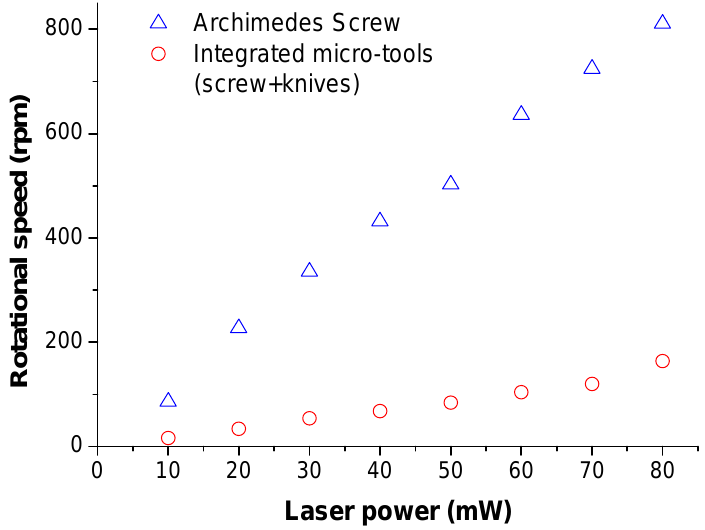
Figure 5. The rotational efficiencies (rpm/mW) of the Archimedes screw and the integrated micro-tool (screw + knives).